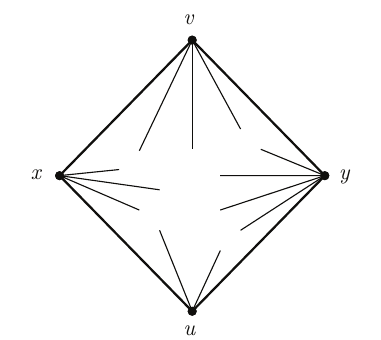
Figure 1. The schematic representation of a near-triangulation with an exterior 4-face. The interior of the graph includes vertices and edges that form triangular